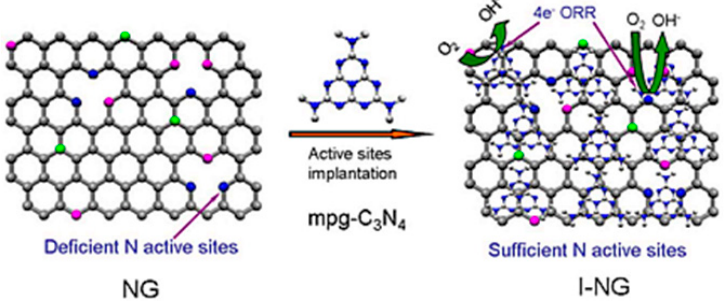
Figure 9. Schematic diagrams of the synergistic interactions between N-doped graphene and mesoporous carbon nitride (mpg-C 3 N 4 ). (Adapted by permission from Macmillan Publishers